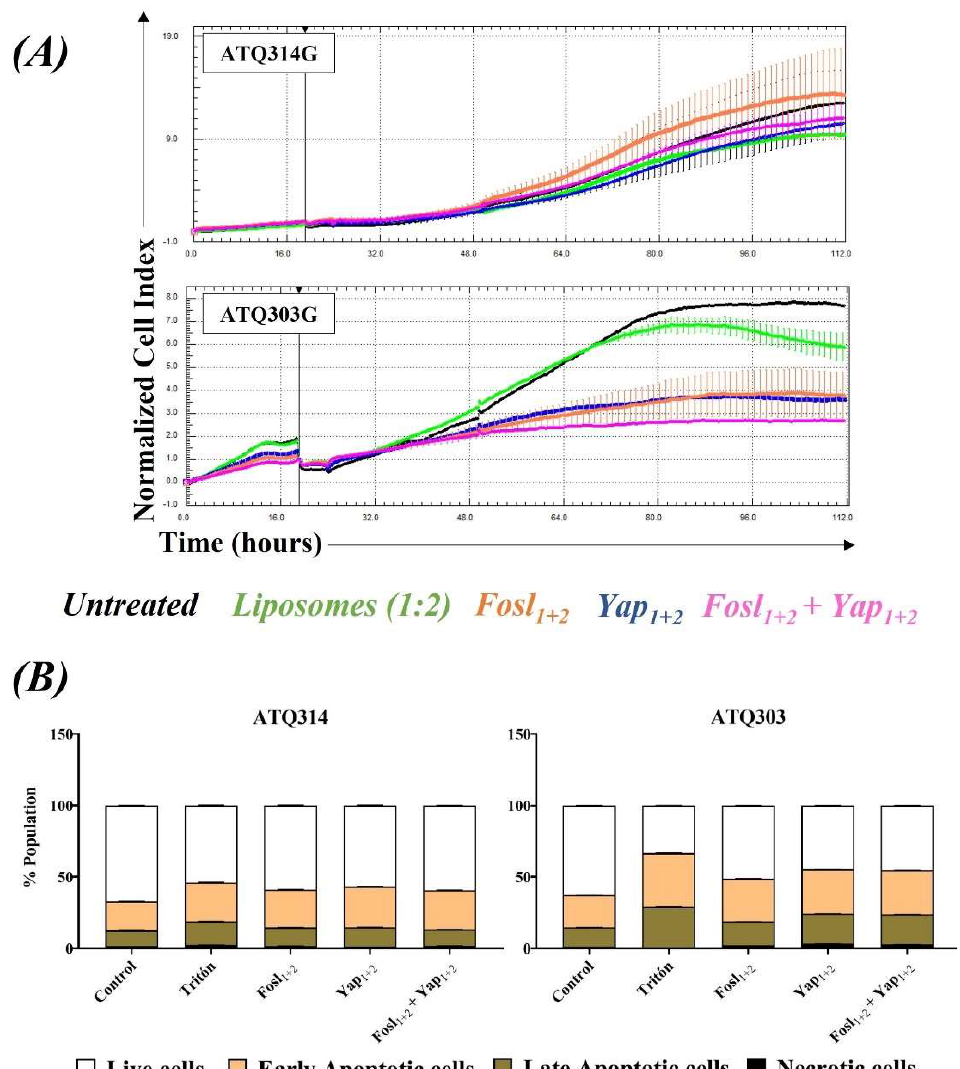
Figure 5. Cytotoxicity of lipoplexes in ATQ314G and ATQ303G cells. ( A ) Kinetics of the normalized cell index of the ATQ314G and ATQ303G cells during 96 h of incubation. ( B ) Percentage of different cell populations (live, early apoptotic, late apoptotic and necrotic cells) after 72 h of incubation determined by flow cytometry. Lipoplexes were tested at 50 nM siRNA and liposomes alone were tested at the equivalent lipid concentration (100 μM). Culture medium was used as negative control.